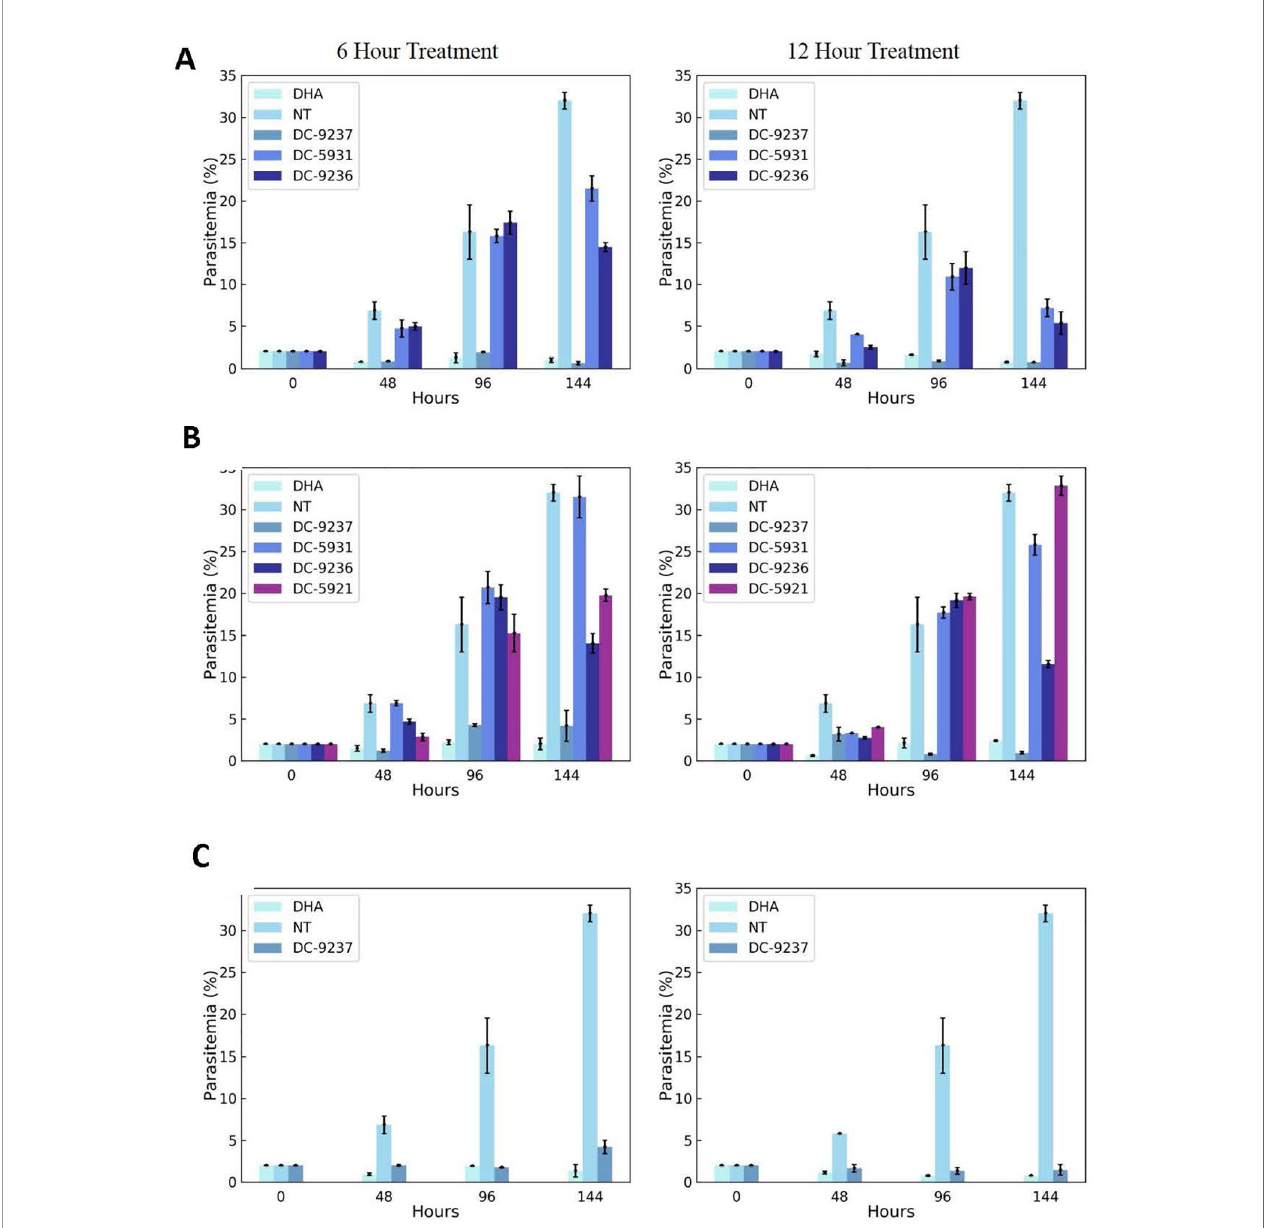
FIGURE 7 | Assessment of rate of killing. Synchronous cultures were subjected to 3 x EC 50 concentrations of macrocyclic compounds or dihydroartemisinin (DHA) for 6 or 12 h, followed by washing to remove the inhibitor and incubating in the growth medium in the absence of compounds to monitor recovery. (A) Compounds added at the schizont stage, (B) treatment at the trophozoite stage, and (C) ring stage culture exposed to the compound. Compounds were added at a stage where they exhibit block in cell cycle